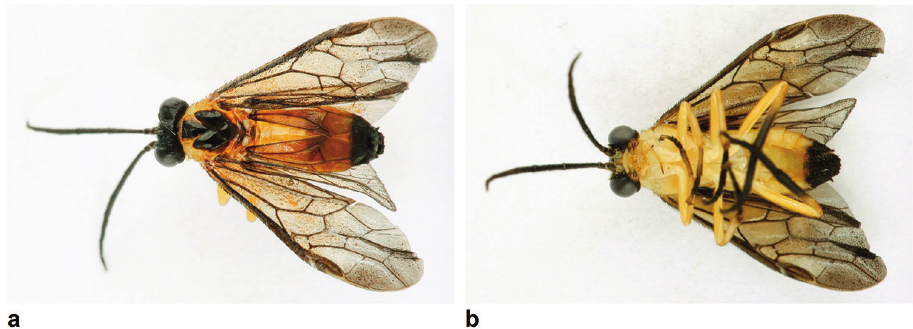
Figure 16. Adiaclema sp., male (P4223.A), body length 7.5 mm. a Dorsal view b ventral view.